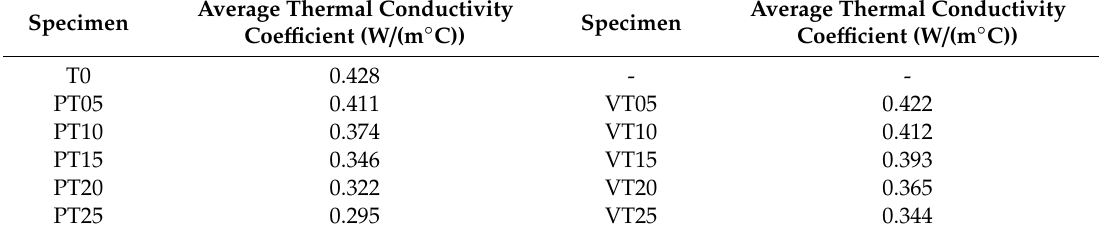
Table 4. The average thermal conductivity coefficient of the specimens.